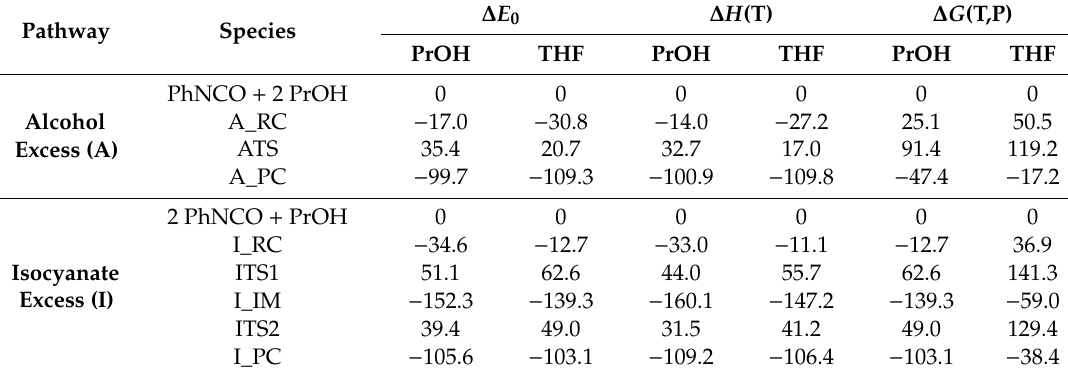
Table 2. G4MP2 thermochemical properties calculated in 1-propanol (PrOH) and in tetrahydrofuran (THF), including zero-point corrected relative energies ( ∆ E 0 ), relative enthalpies ( ∆ H (T)) and relative Gibbs free energies ( ∆ G (T,P)) at T = 298.15 K, and P = 1 atm. (A) according to alcohol excess, and according to isocyanate excess (I). All values are in kJ /